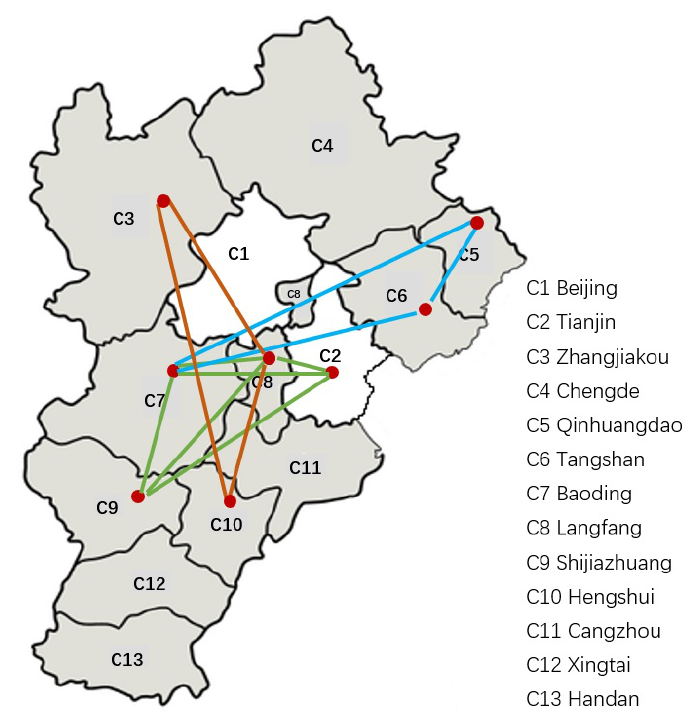
Figure 5. City pairs and city groups with a time difference for the occurrence of extreme ozone pollution in the BTH Region. Green lines represent the co-movement of a simultaneous city group, blue lines show the 12-h city group, and the orange lines represent the 24-to-48-h city group. These four cities are all in the middle of the BTH Region. Their close geographical location is one of the key reasons for the co-occurrence of extreme ozone